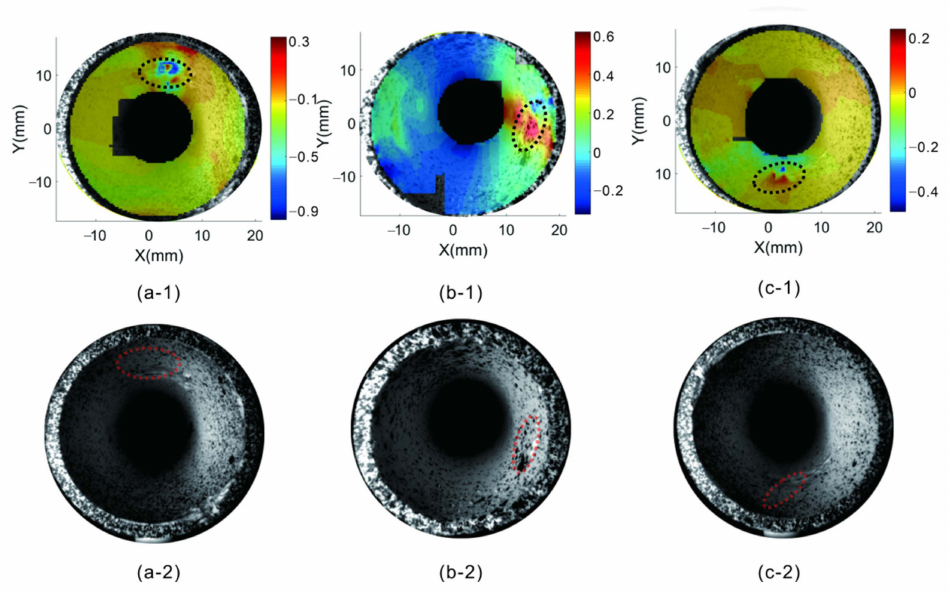
Figure 13. Strain distribution of defects at different positions: ( a ) upper part; ( b ) on the right side; ( c )